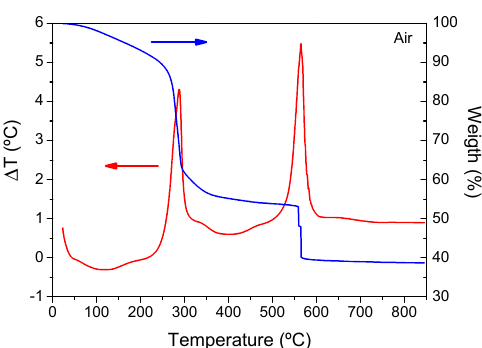
Figure 3. Differential thermal analysis (DTA, red) and thermogravimetry (TG, blue) curve for 80SiO 2 -20LaF 3 -0.5Er 3+ (TEOS-MTES) bulk sample treated in the air with a heating rate of 10 ° C/min.